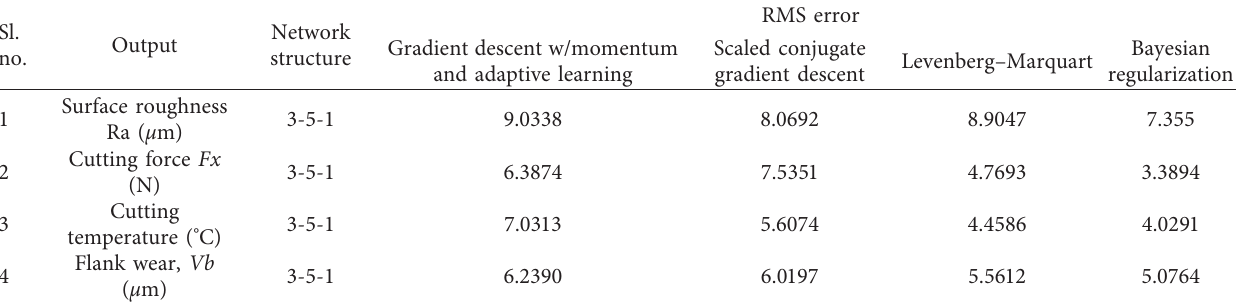
Table 5: Analysis of different activation functions for training and